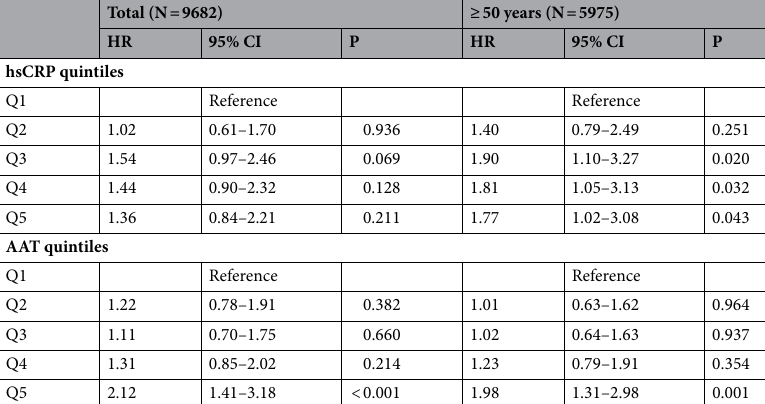
Total (N = 9682) ≥ 50 years (N =